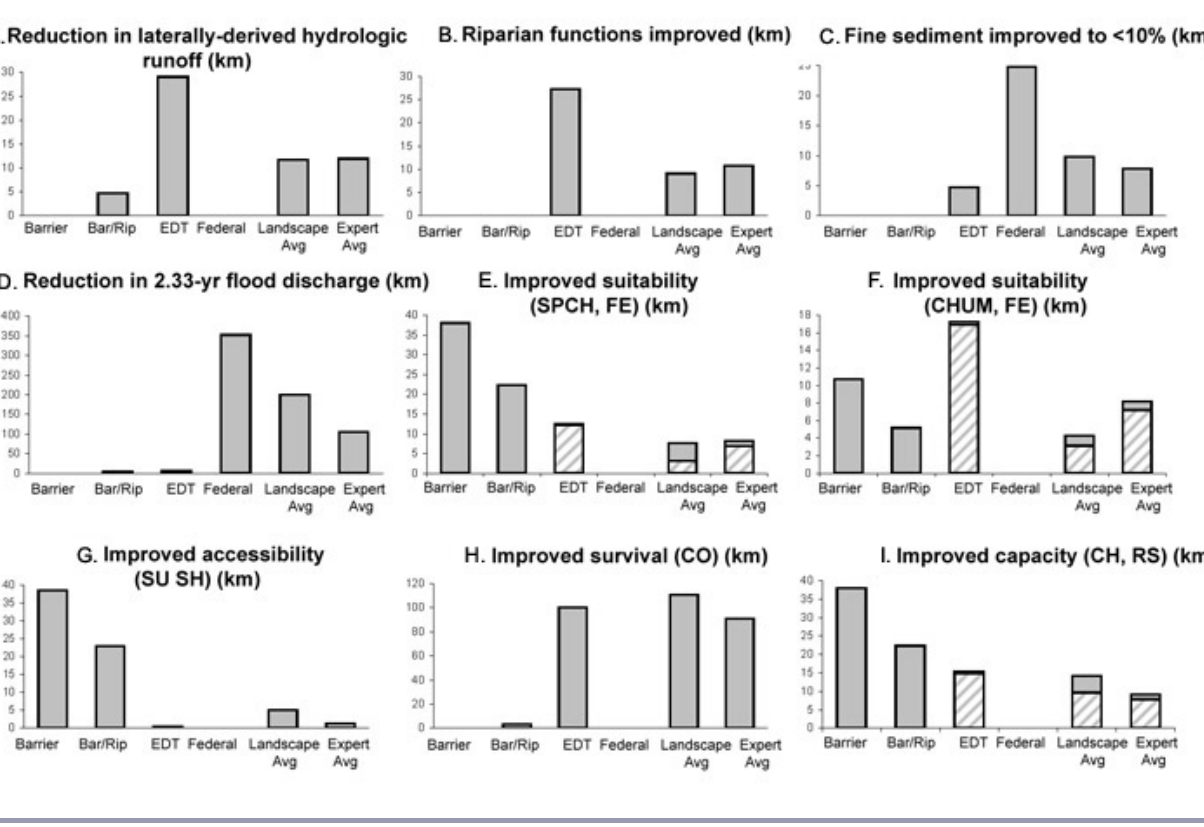
Fig. 4. Habitat and biological responses to the six watershed management strategies. Panels A–D are summarized over all reaches. Panels E–I are summarized over all reaches accessible to winter steelhead in the future landscape being evaluated. Predicted responses to the landscape and expert strategies are presented as the average over all modeled landscapes. In panels E, F, and I, the solid bars describe increases in suitability or capacity that result from increased accessibility and the hatched bars represent increases in suitability or capacity that result from improvements in the quality of habitat that was accessible under current conditions. Note that the y-axis-scale changes between metrics. spring Chinook salmon (SPCH); summer steelhead (SUSH), coho salmon (CO), Chinook salmon (CH), FishEye model (FE), remotely sensed capacity model